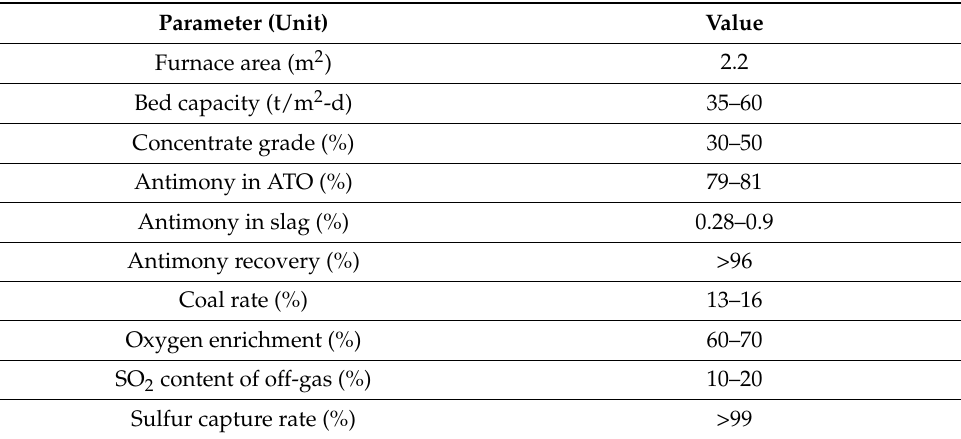
Table 6. CSC commercial test parameters (adapted from